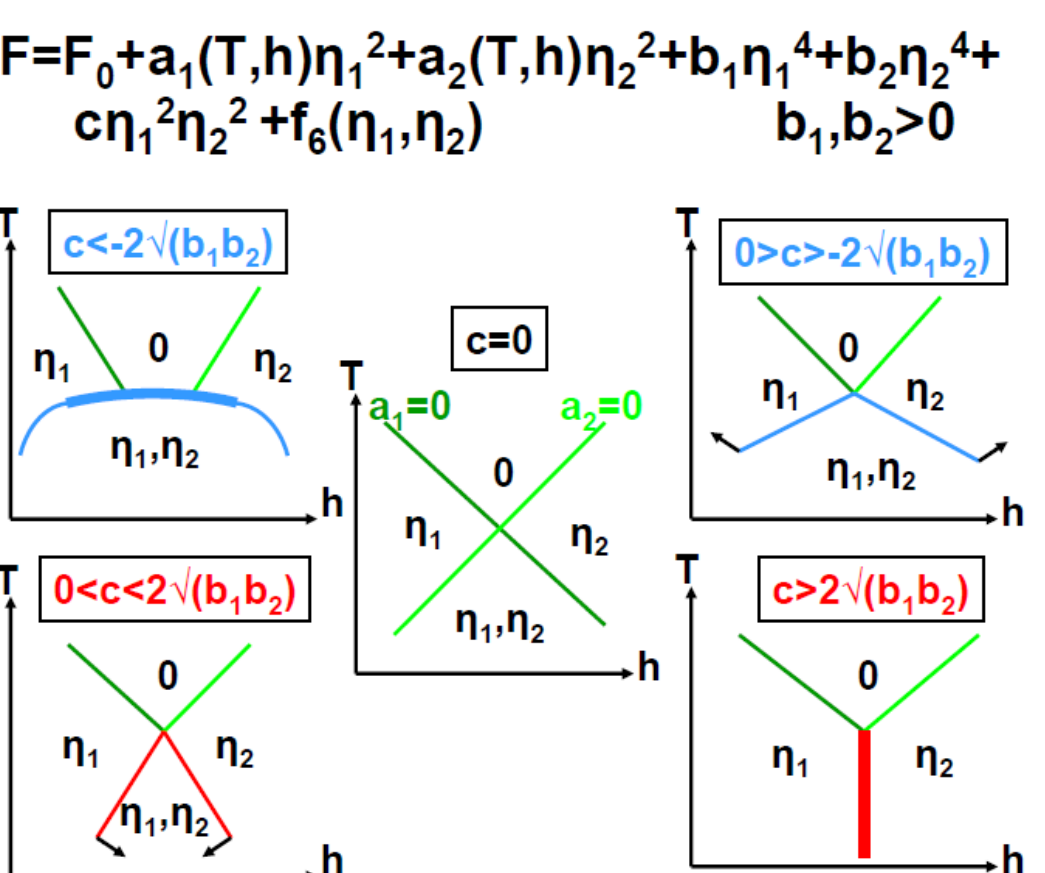
Figure A1. Phase diagrams of the Landau free energy, written on top of the figure, in function of the temperature (T) and of an external parameter, h, allowing the variation of the Landau coefficients a . In the figure both b and b are positive. The value and sign of i 1 2 the coupling c between the order parameters are indicated for each phase diagram. Thin (thick) lines represent 2 nd (1 st ) order transition lines. The phases are labeled by the order parameter which differs from zero. “0” corresponds to the non modulated (η = η = 0) 1 2 phase. The critical temperature achieving pure η or η phases on each side of the phase 1 2 “0” trough 2 nd order transitions (thin green lines) is given by a = 0 or a = 0 respectively. 1 2 The arrows connected to the 2 nd order transition lines (thin red (blue) lines) delimiting the (η , η ) phase for 0 < c < 2√(b b ) (0 > c > −2√(b b )) indicate the sense of displacement of 1 2 1 2 1 2 the phase boundaries when c increases (c decreases). This displacement shows, when c > 2√(b b ), that the (η , η ) phase collapses to a first order transition (thick red line) 1 2 1 2 linking the pure η and η phases. When c < −2√(b b ), the expansion of the (η , η ) phase 1 2 1 2 1 2 renders this phase directly reachable from the “0” phase through a first order phase transition (thick blue